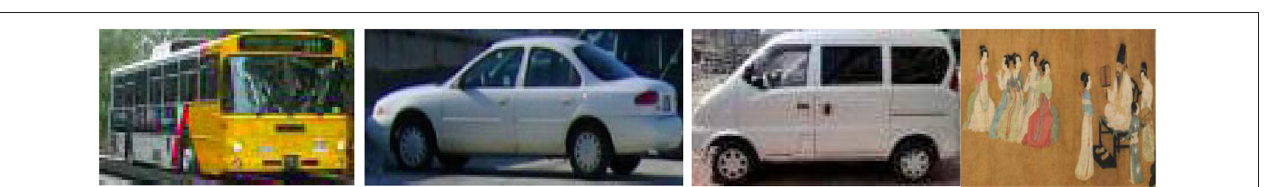
FIGURE 5 | Sample A.